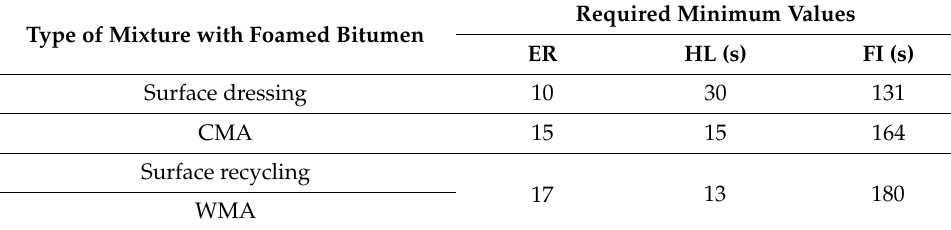
Table 12. Required values of bitumen foam parameters by use of the binder [16]. Type of Mixture with Foamed